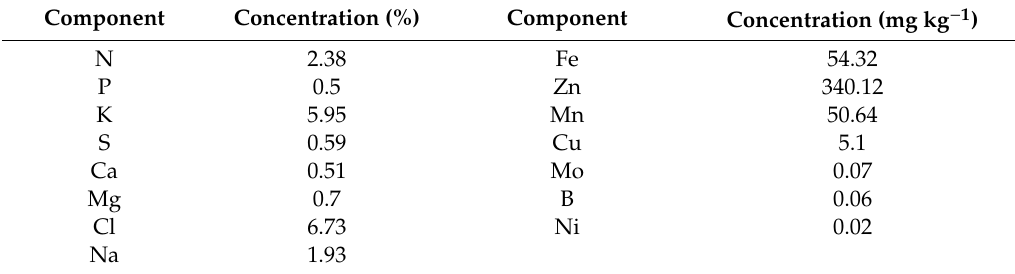
Table 1. The concentrations of 15 mineral elements in Condensed Molasses Soluble